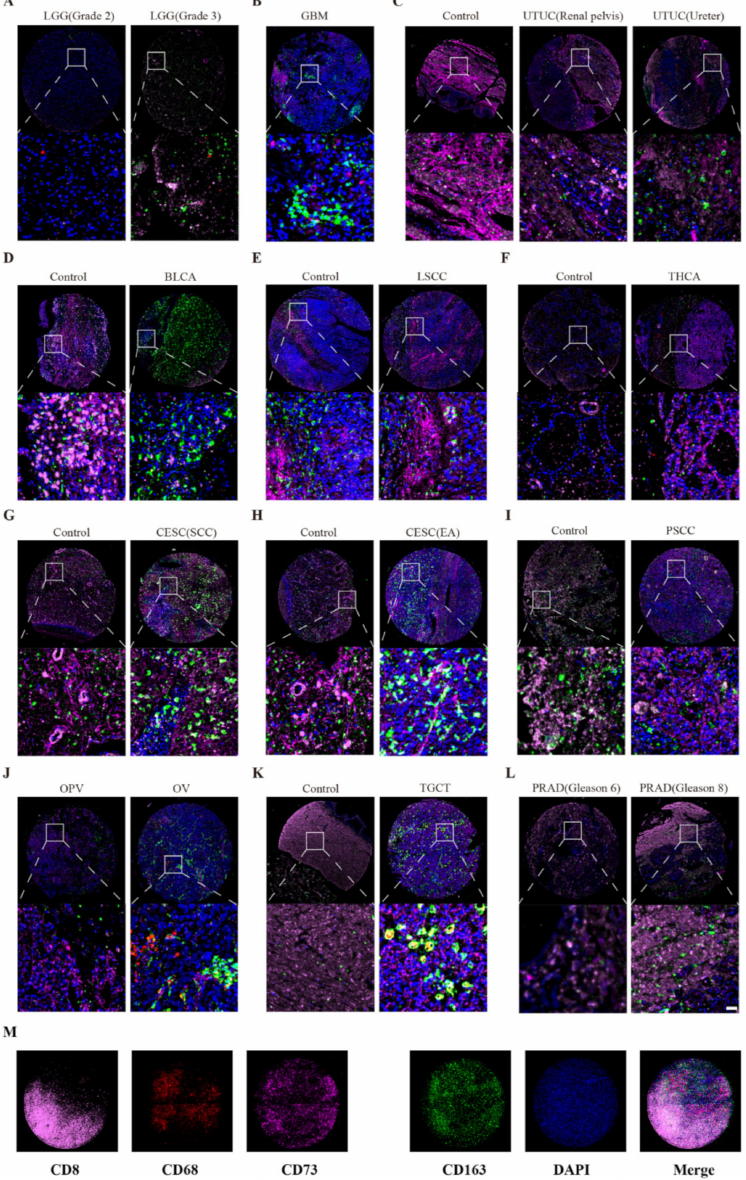
Figure 7. Triple immunofluorescences analyze the co-expression of CD73 in pan-cancer chip. Re- lationship between CD73 and CD8, CD163 and CD68 expression in LGG ( A ), GBM ( B ), UTUC ( C ), BLCA ( D ), LSCC ( E ), THCA ( F ), CESC ( G , H ), PSCC ( I ), OV ( J ), TGCT ( K ), and PRAD ( L ), Immunofluorescence markers ( M ). Scale bar = 40 µ